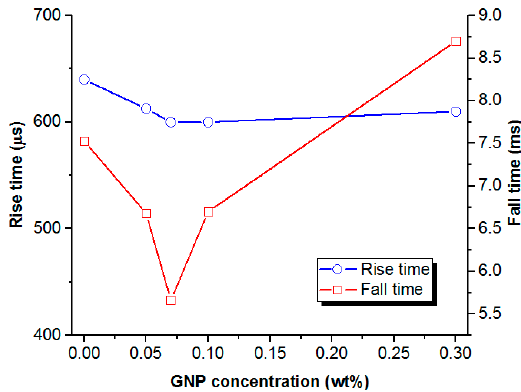
Figure 4. Rise and fall times of LC cells doped with various GNP concentrations.